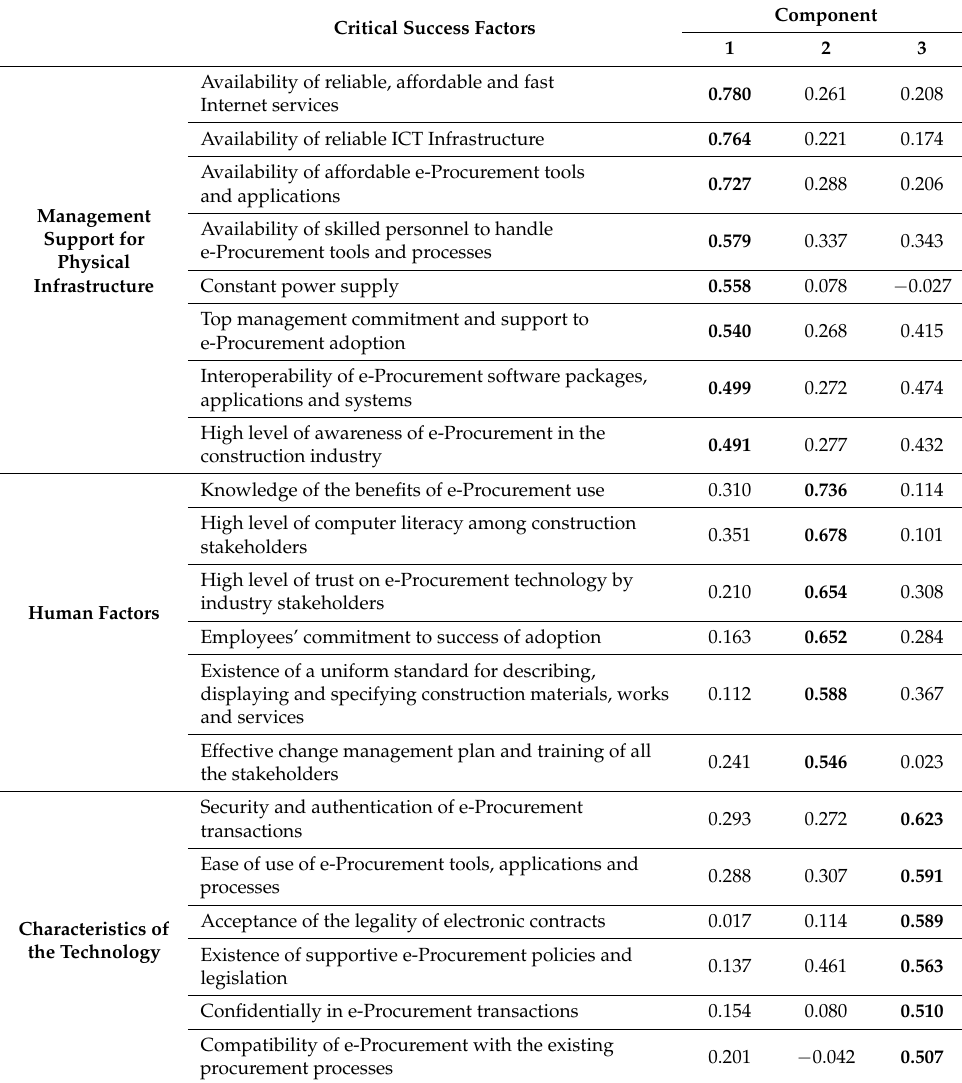
Table 8. Rotated Component Matrix a on CSFs for the adoption of e-Procurement